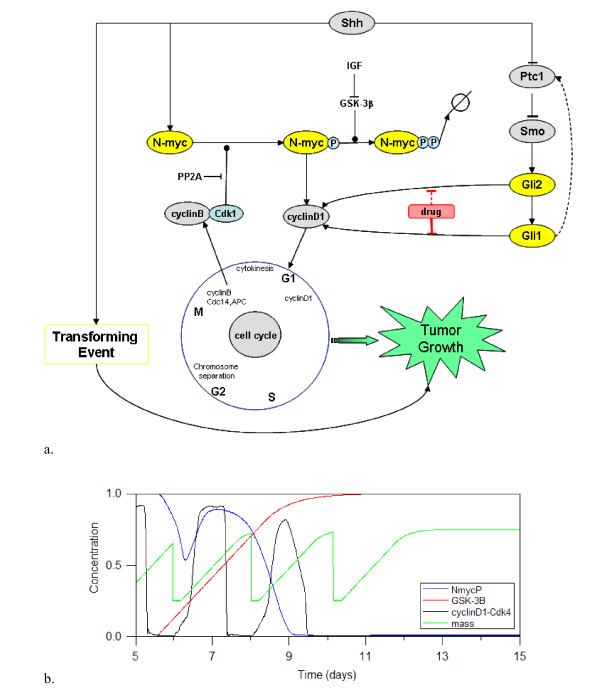
In this model, the tumor growth process is replaced with the cell cycle model from figure 7. Components of the hedgehog pathway now interact directly with cyclin D1; mitotic cyclin (cyclin B) is required for Nmyc phosphorylation to the active Nmyc-P state. b. If the cell cycle is activated by injecting Nmyc-P initially, the effect of other components on the cycle can be studied. In this figure, IGF is decreased beginning on day 6, allowing GSK-3β to increase. Nmyc-P is then phosphorylated and degraded. The effects of drug dose will be the same for this model as in figure 9, as the primary action of the drug on Gli2 has not been changed. However, adding details to the cell cycle now allows more detailed investigation of the interaction between the drug, its targets, and cell cycle components.